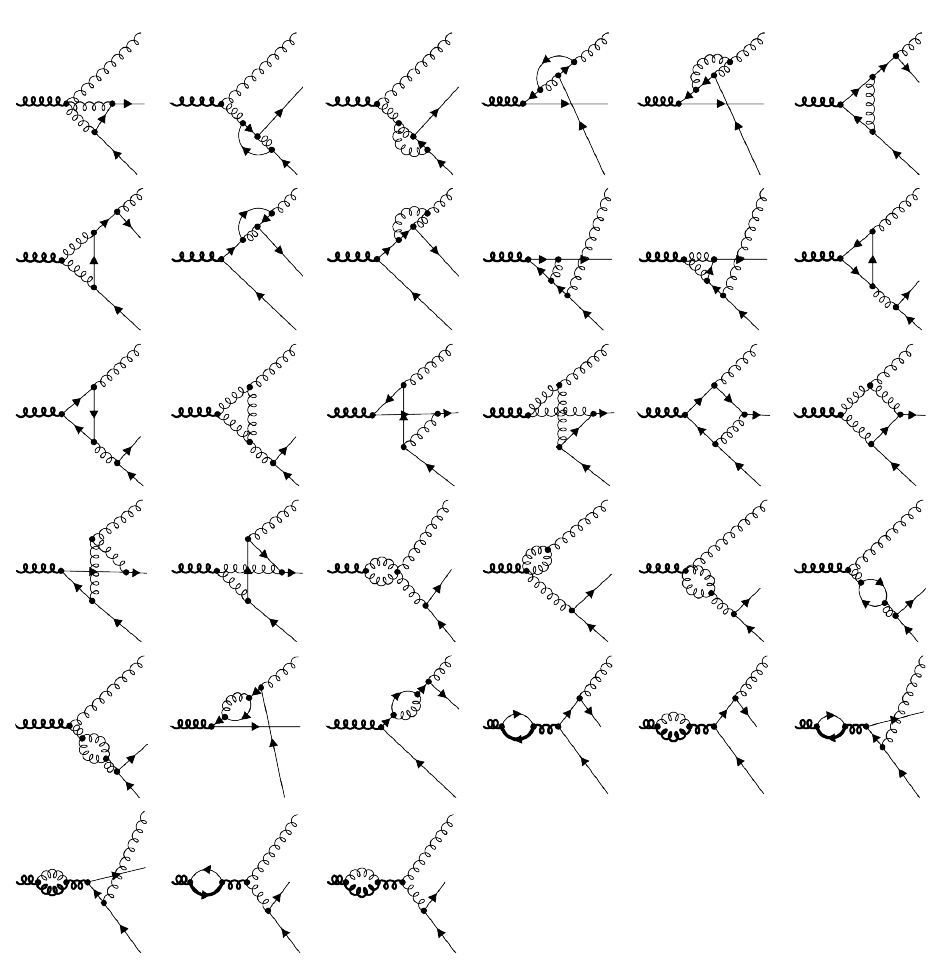
Figure 4 . 33 diagrams contributing to the splitting operator g → gq ¯ q . Description as in figure